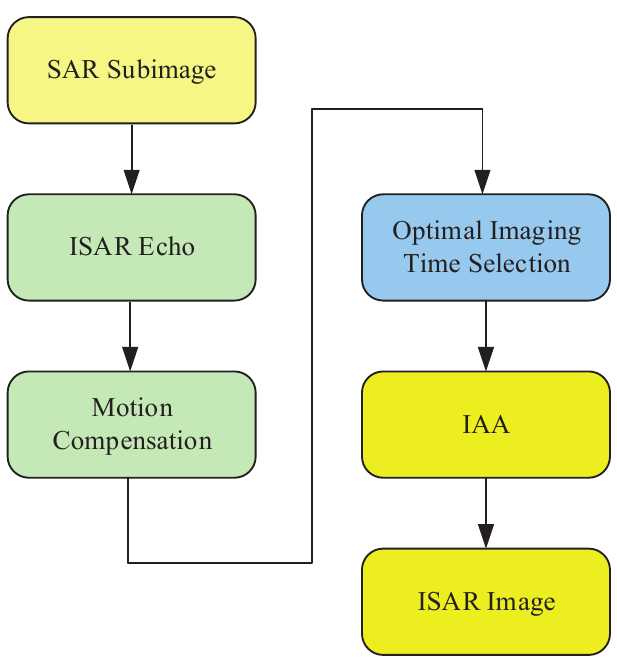
Figure 3. The flowchart of the proposed